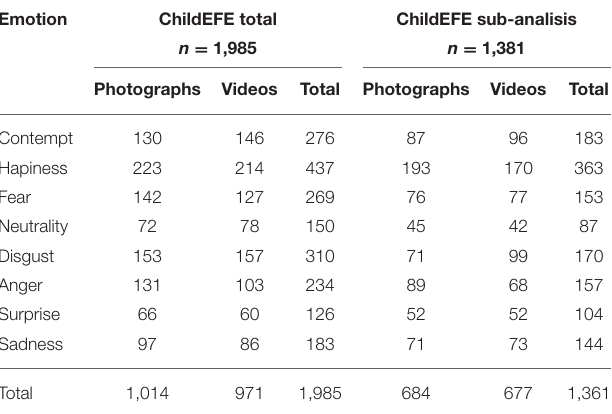
TABLE 6 | Comparison of the distribution of photographs and videos by emotions from ChildEFE total vs. ChildEFE sub-analysis. Emotion ChildEFE